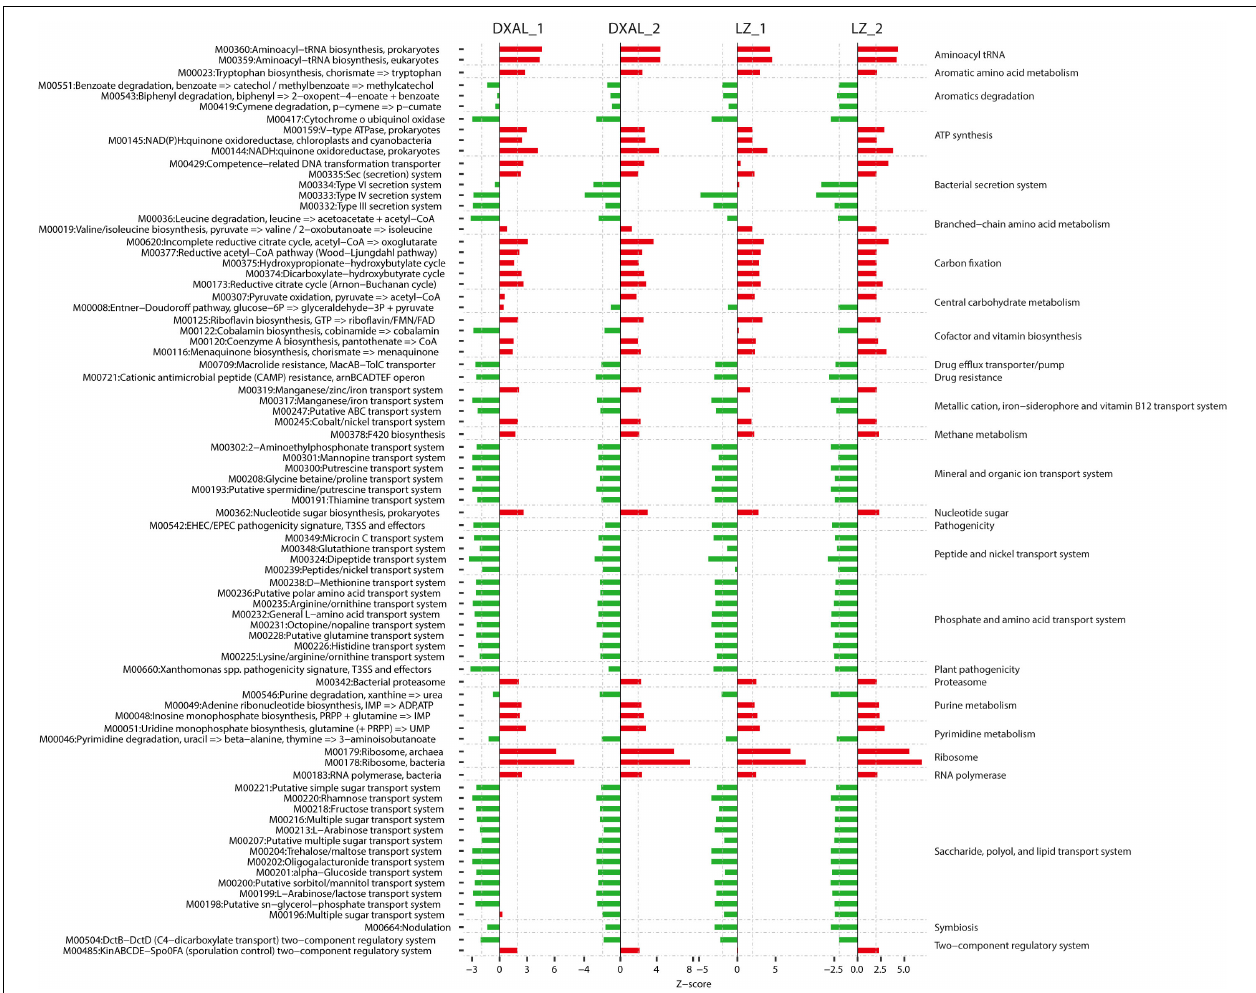
FIGURE 5 | Alterations in bacteria microbial functional modules in each compare group. Dashed lines indicate a reporter score of 1.96, corresponding to 95% confidence in a normal distribution. DXAL_1: DXAL_1_Root vs. DXAL_1_Soil, DXAL_2: DXAL_2_Root vs. DXAL_2_Soil, LZ_1: LZ_1_Root vs. LZ_1_Soil,